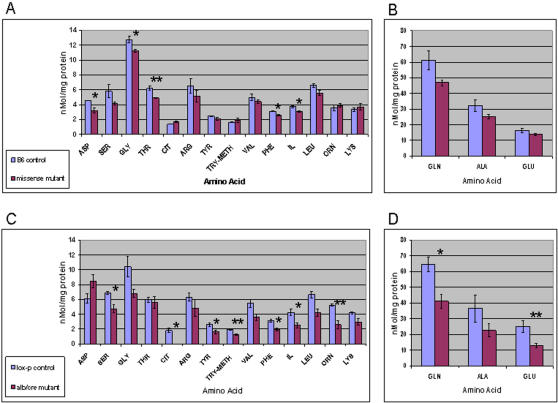

Pdss2 Mutants Have Altered Amino Acid Profiles in Liver.
Pdss2 mutants have altered amino acid profiles in liver. Quantitative liver amino acid analysis detects significant differences in B6.Pdss2kd/kd missense mutants compared with B6 controls (Panels A and B), as well as in B6.Alb/cre,Pdss2loxP/loxP mutants compared with B6.Pdss2loxP/loxP controls (Panels C and D). To better demonstrate differences in all amino acids, results for three amino acids in highest abundance are shown separately (Panels B and D) with a greater scale compared to that used for the remainder of the amino acids present in relatively lower abundance (Panels A and C). Values represent mean +/− SEM. Statistical analyses comparing mutants and controls were performed by Student's t-test, where * indicates p<0.05 and ** indicates p<0.01.